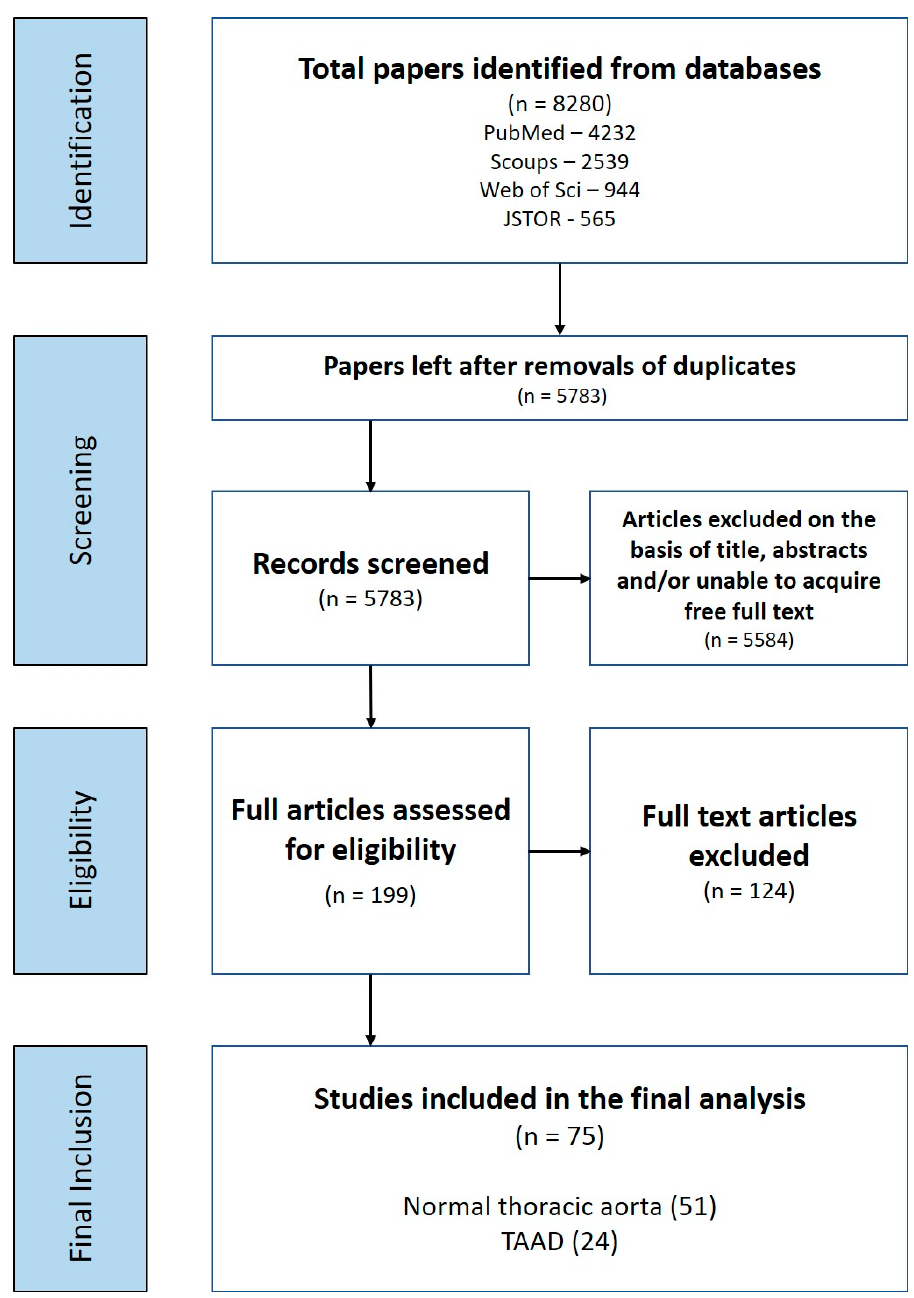
Figure 2. Search process for healthy aorta and sporadic TAAD . PRISMA flow depicting the search process for the role of GAGs/PGs in the normal aorta and sporadic TAAD. All papers were included as a whole throughout the data extraction, then separated into two categories; normal thoracic aorta (51) and TAAD (24), after the final inclusion stage.